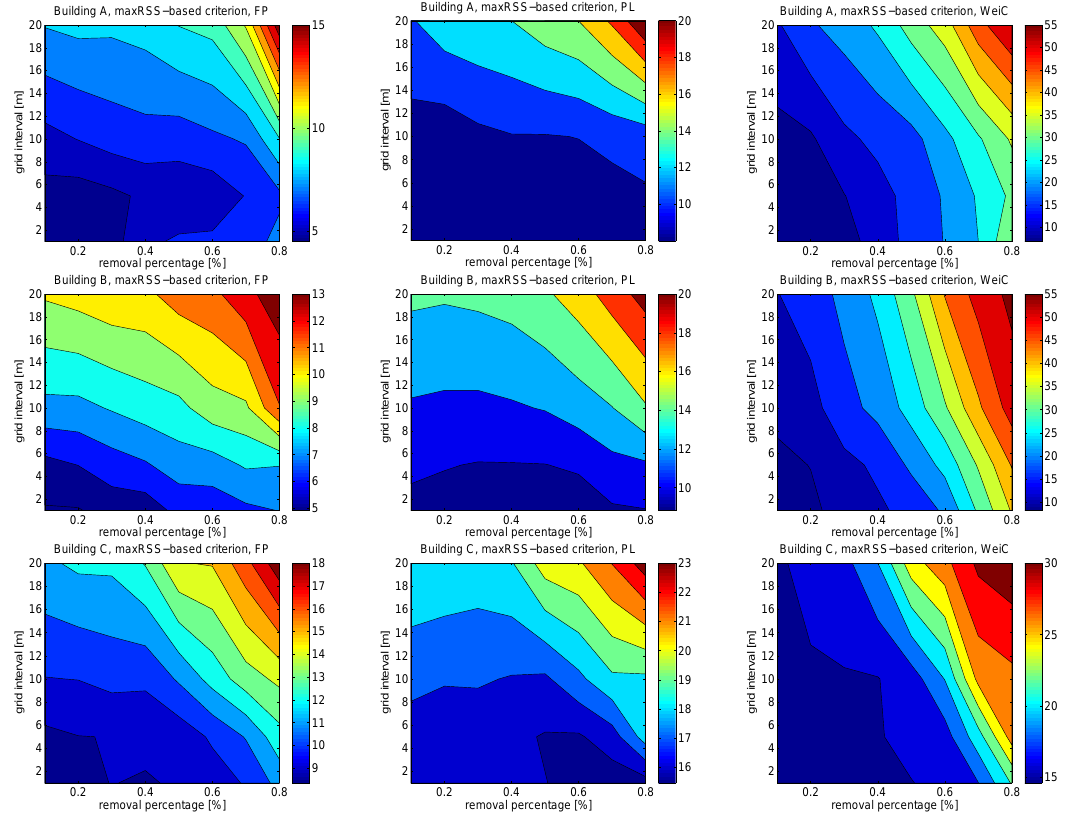
Figure 3. Effects of AP removal and grid size for buildings A, B and C. FP, PL and WeiC positioning positioning approaches and maxRSS-selection